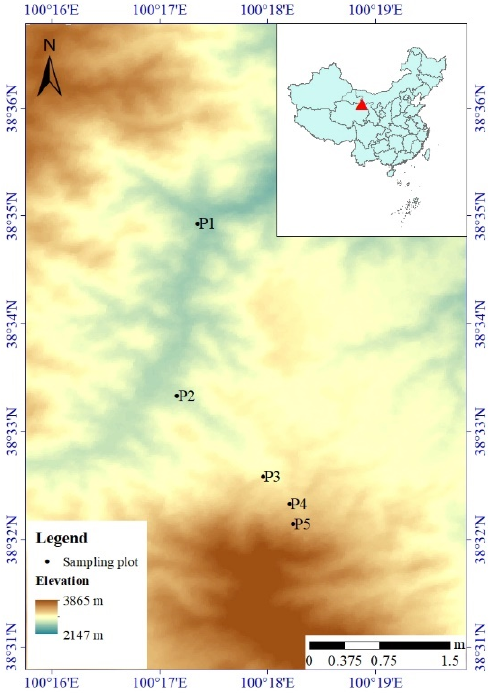
Figure 1. The digital elevation model (DEM) of the study area showing the locations of Qinghai spruce plots. P1 to P5 represent the locations of five plots at elevations of 2500 m, 2700 m, 2900 m, 3100 m and 3300 m, respectively.